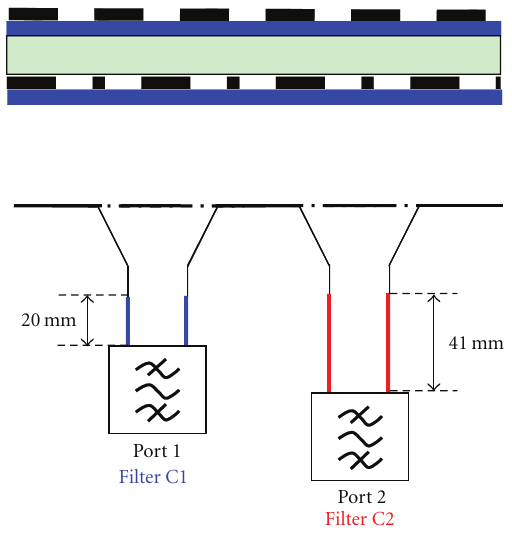
Figure 17: Multifeed EBG antenna connected to filters by waveg- uide length.